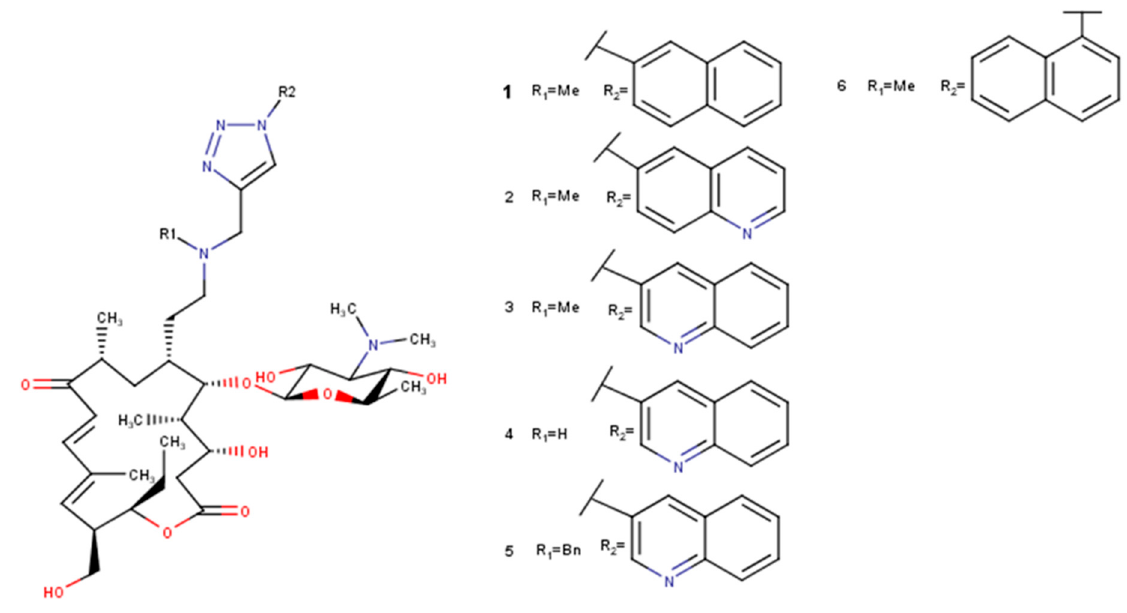
Figure 3. Selected derivatives 1 – 6 of 5- O -mycaminosyltylonolide.